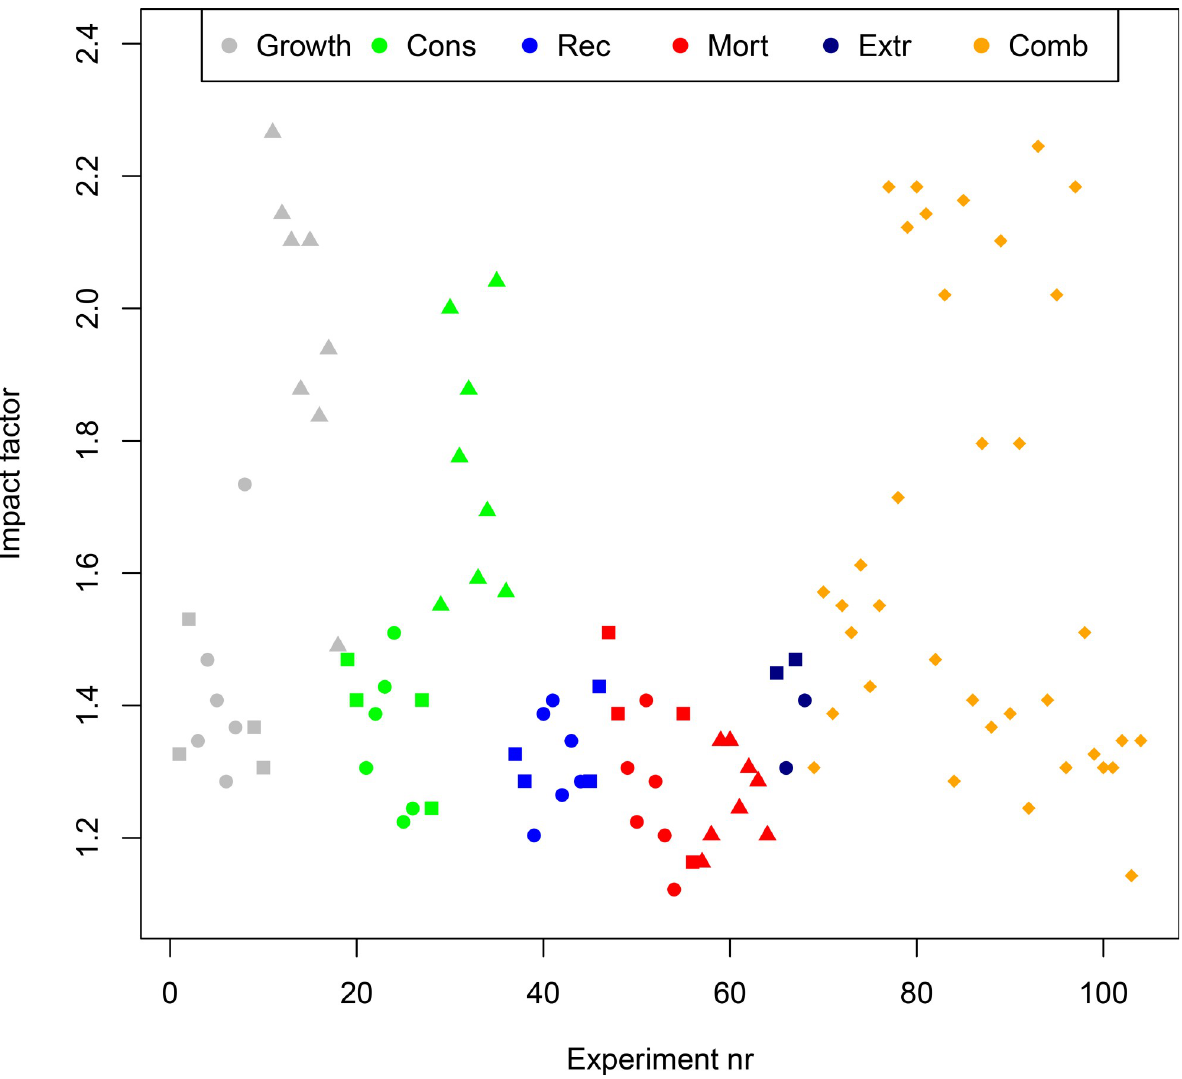
Fig 2. Impact factor. The figure shows the impact factor of all the simulations. The impact factor indicates how many species experience a change in the biomass and is weighted according to the magnitude of the impact. The experiments are color-coded according to which parameter is tuned, where grey is growth rate (Growth), green is consumption rate (Cons), red is mortality rate (Mort), blue is recruitment (Rec), dark blue are the extreme (Extr) parameter changes, and orange represents combination runs (Comb). In addition, the shape of the dot indicates which trophic level that has been perturbed. Triangles represents perturbations at zooplankton level, squares at top predator level, circles at mid-level and diamonds represents combined runs.